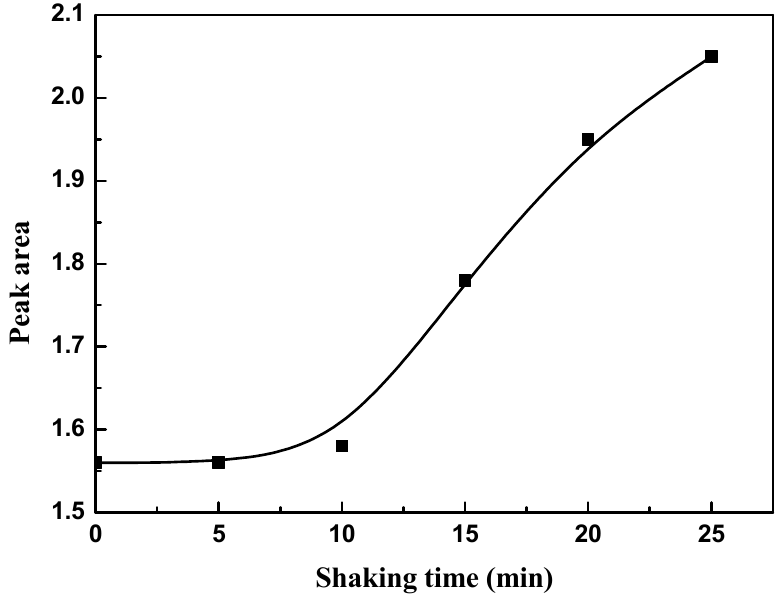
Figure 6. Effect of shaking time on the adsorption of Tyr amino acid on GO.